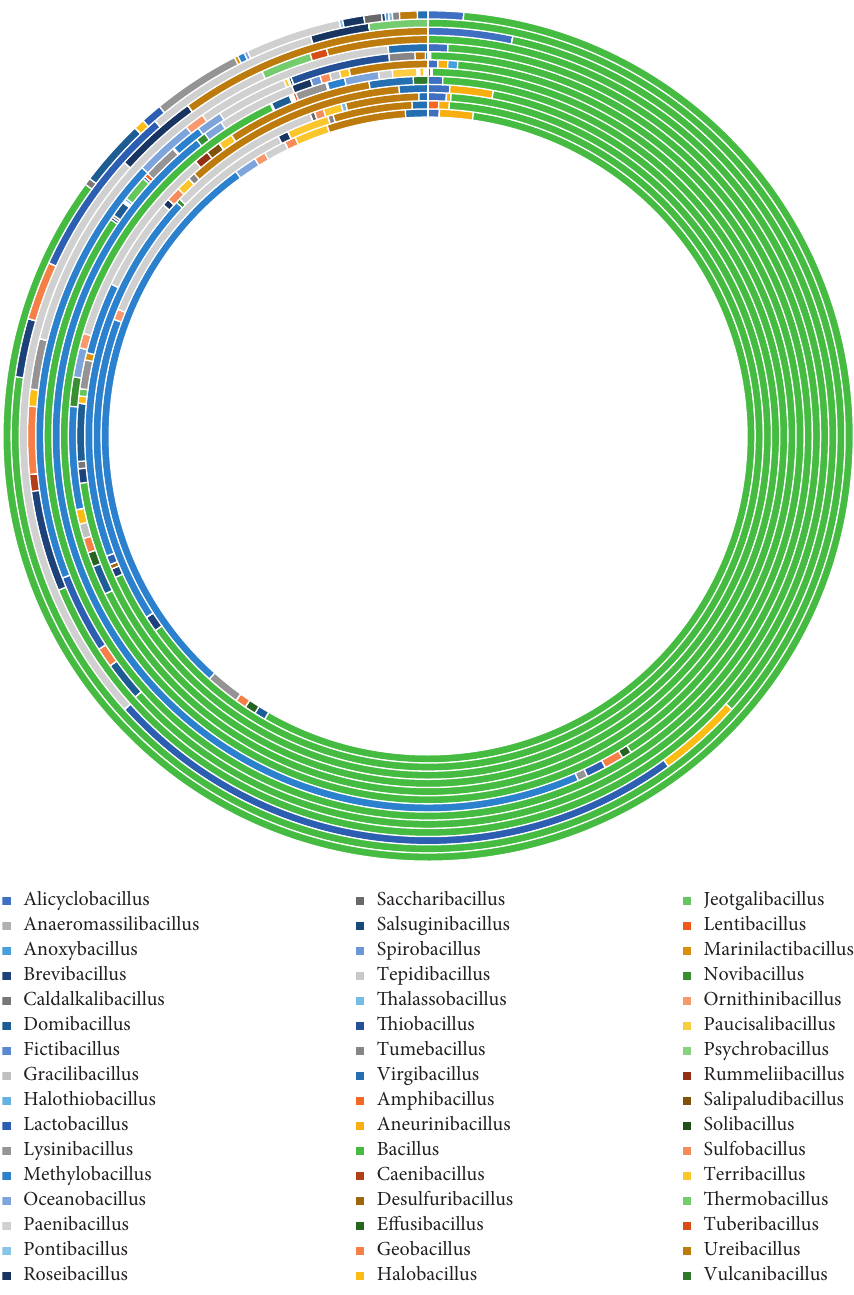
Figure 16: Relative abundance of Bacillus- related sequence reads in Pierce College